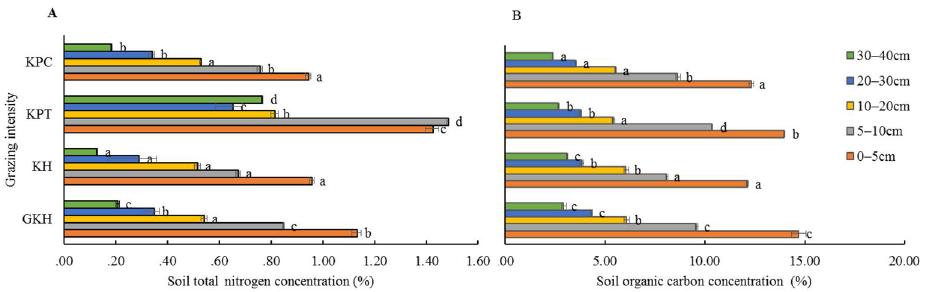
Figure 7. Concentrations of total nitrogen (N) ( A ) and total organic carbon (C) ( B ) in the plant com- munity at different grazing intensities: GKH (3.75 ± 0.75 sheep/ha), KH (7.25 ± 0.25 270 sheep/ha), KPT (8.50 ± 0.35 sheep/ha), and KPC (11.75 ± 0.95 sheep/ha). Notations: different letters indicate significant differences between pastures ( α = 0.05).